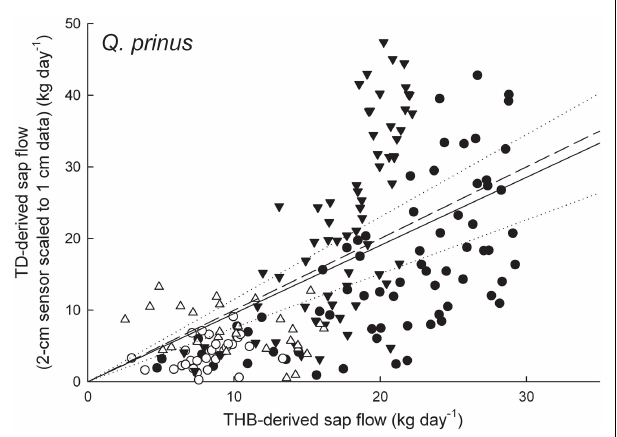
FIGURE 5 | Quercus prinus daily sap flow rates (kgday − 1 ) derived from the tissue heat balance (THB) system compared with rates derived from 2-cm long thermal dissipation (TD) sensors (no Clearwater correction applied) that were scaled using data from 1-cm longTD sensors (Figure 4). The closed circles denote data from a 17.7-cm dbh individual, open circles denote data from a 16.8-cm dbh individual and the triangles denote data from a 16.8-cm dbh individual measured in 2009 (closed) and 2010 (open).The dashed line is the one to one line, the solid line is the best fit regression( y = 1.15 x − 3.83, r 2 = 0.41) to the data and the dotted lines are the 95% confidence intervals around the linear regression.